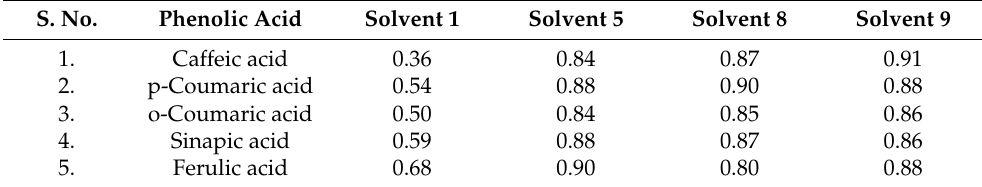
Table 7. Rf value of standards in different solvents *.